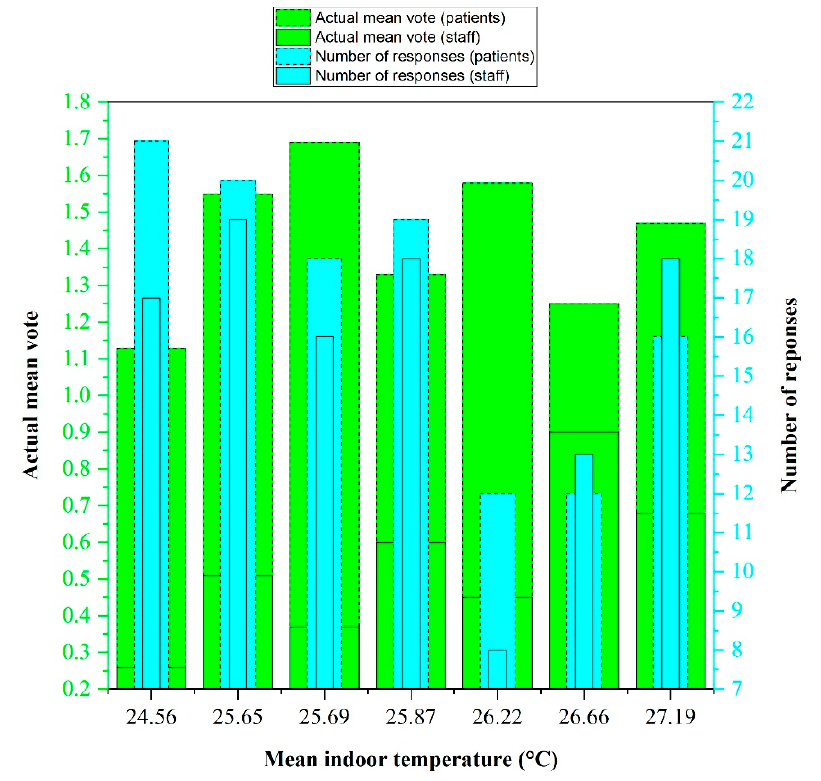
Figure 15. Difference in the subjective thermal sensations of patients and staff.